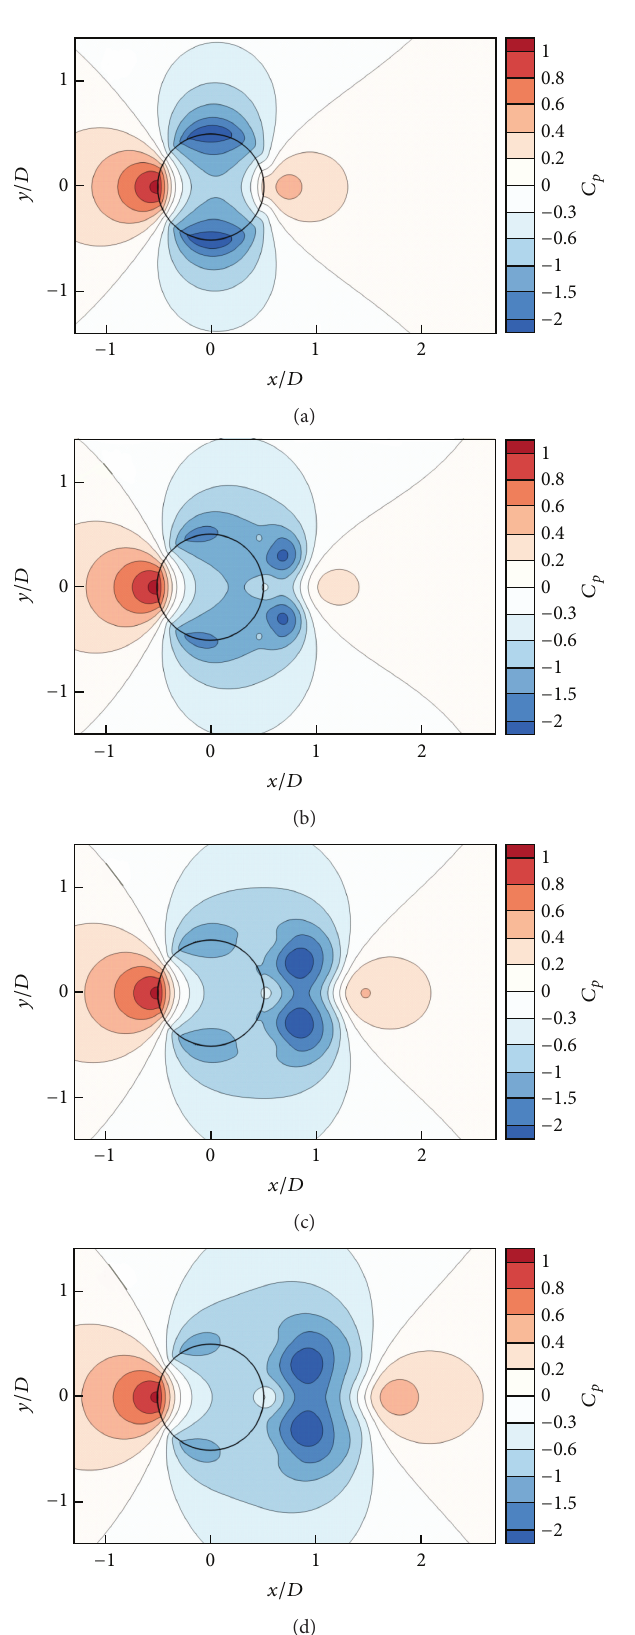
Figure 5: Pressure coefficient distribution around a circular cylin- der for Re = 550 : (a) 𝑇 = 1 , (b) 𝑇 = 3 , (c) 𝑇 = 5 , and (d) 𝑇 = 7 .